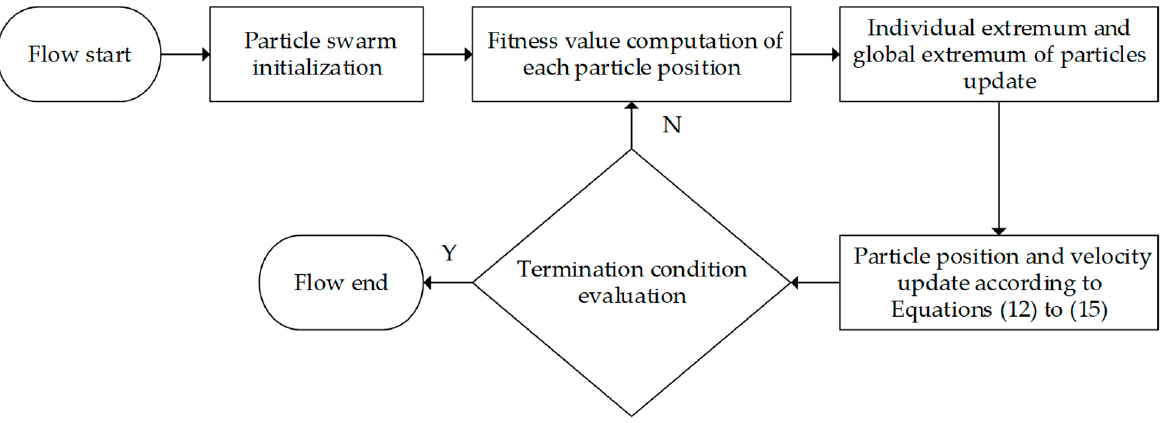
Figure 7. Flowchart of optimizing SVR with IPSO.